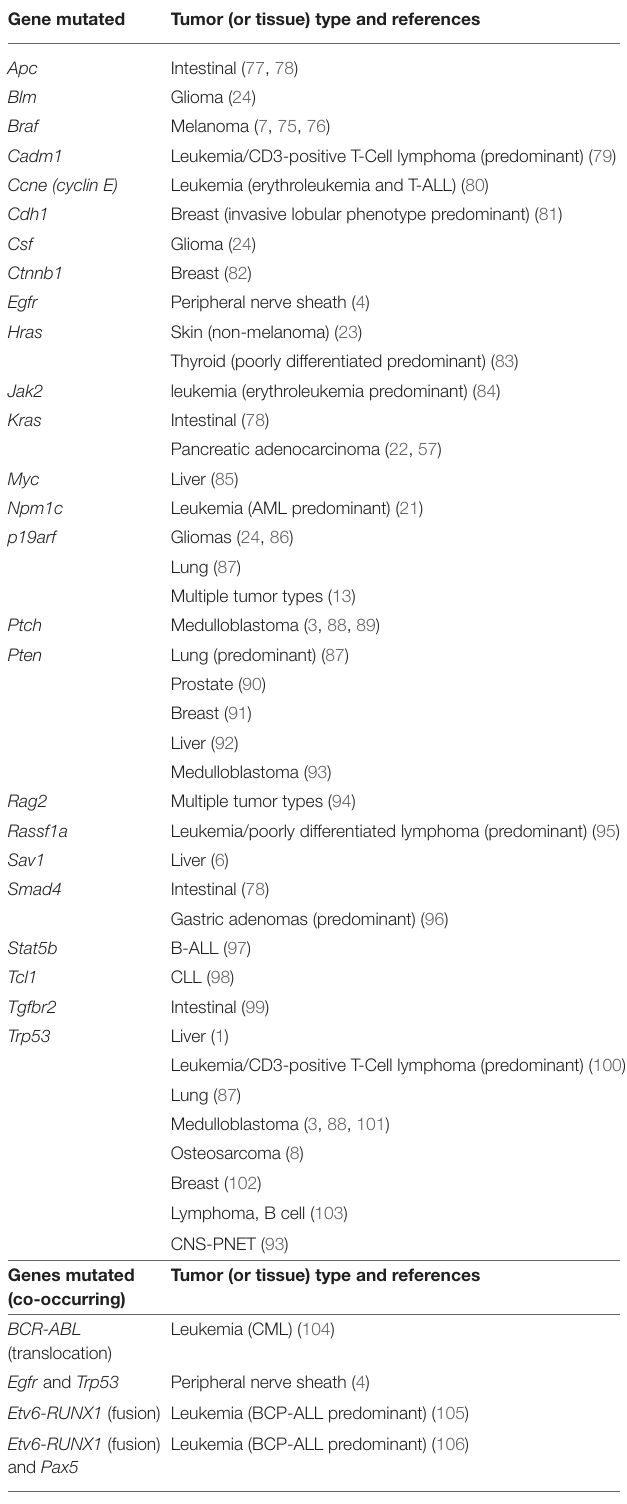
TABLE 1 | Sensitizing mutations used in SB cancer